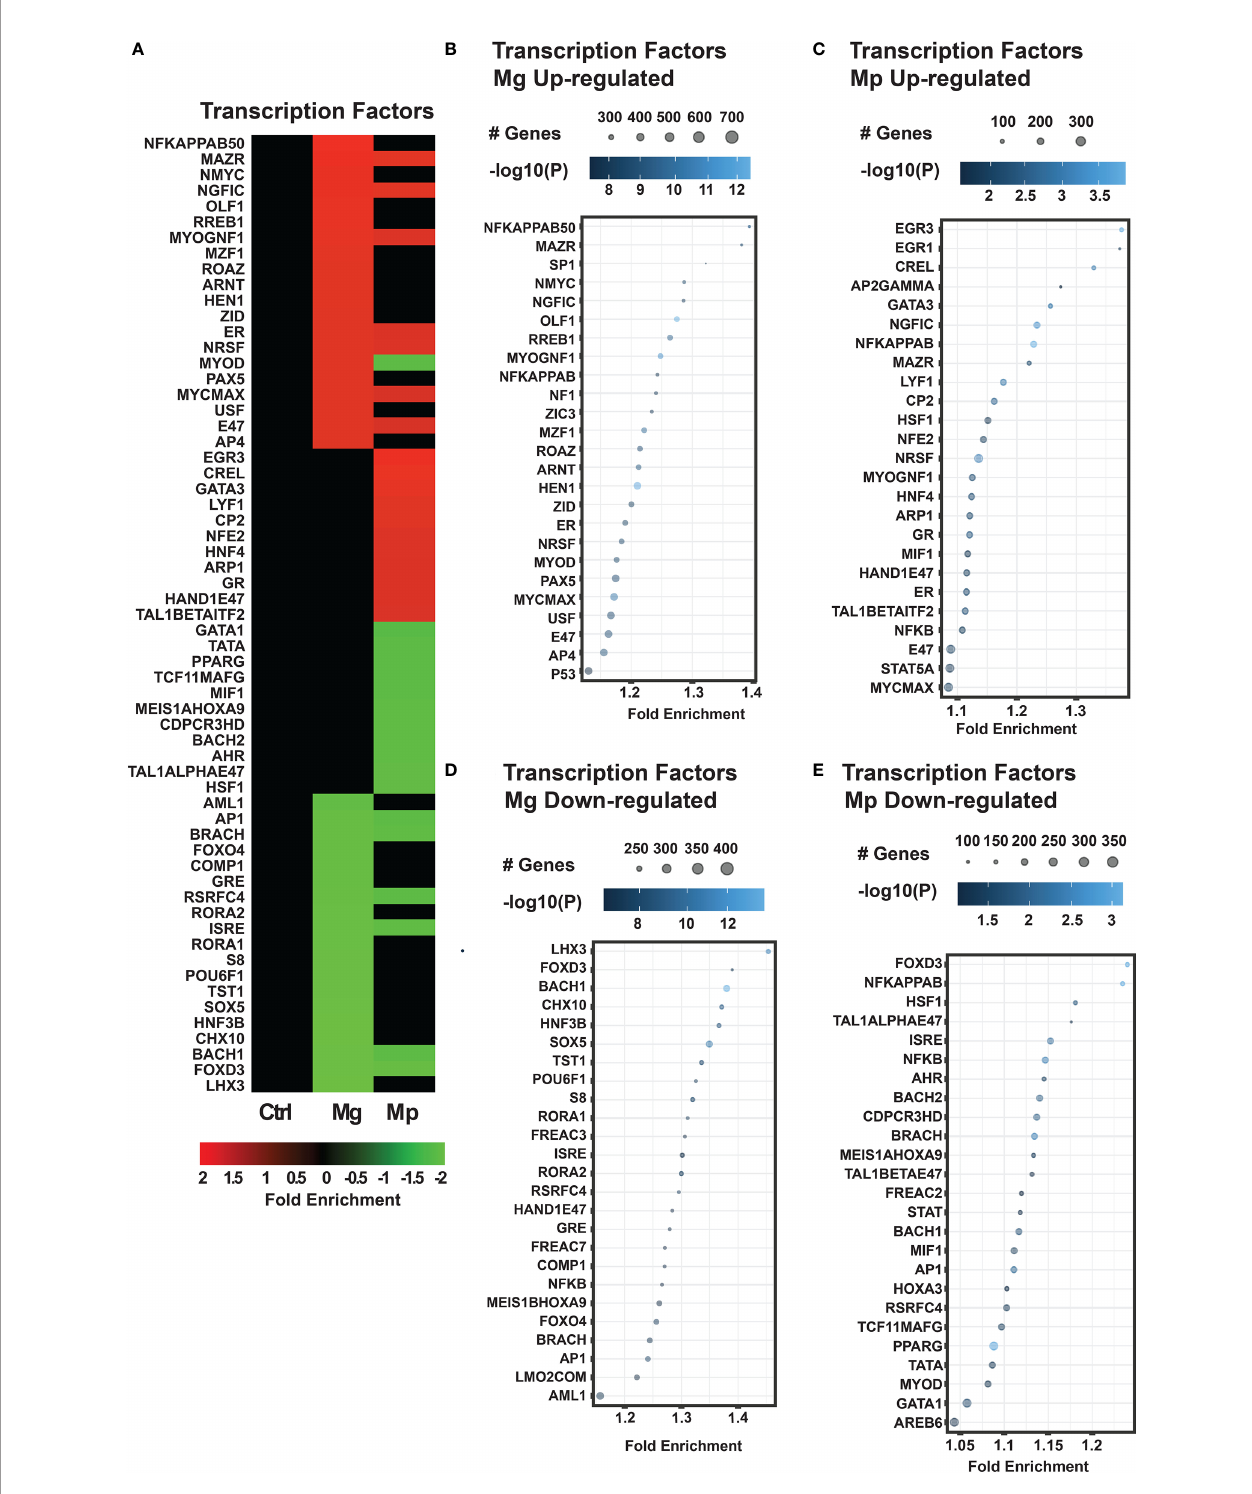
FIGURE 6 | M. genitalium (Mg) and M. pneumoniae (Mp) regulate gene targets of speci fi c transcription factors. (A) Transcription factor heat map showing fold enrichment pro fi les. Quanti fi cation of transcription factors enrichment in the RNA-seq dataset by dot blots for each condition: (B) Mg up-regulated, (C) Mp up- regulated, (D) Mg down-regulated, and (E) Mp down-regulated. Dot blots measure fold enrichment of the pathways, and dot size represents total number of genes included in each category, and gradient color shows statistical signi fi cance [-log 10 ( P